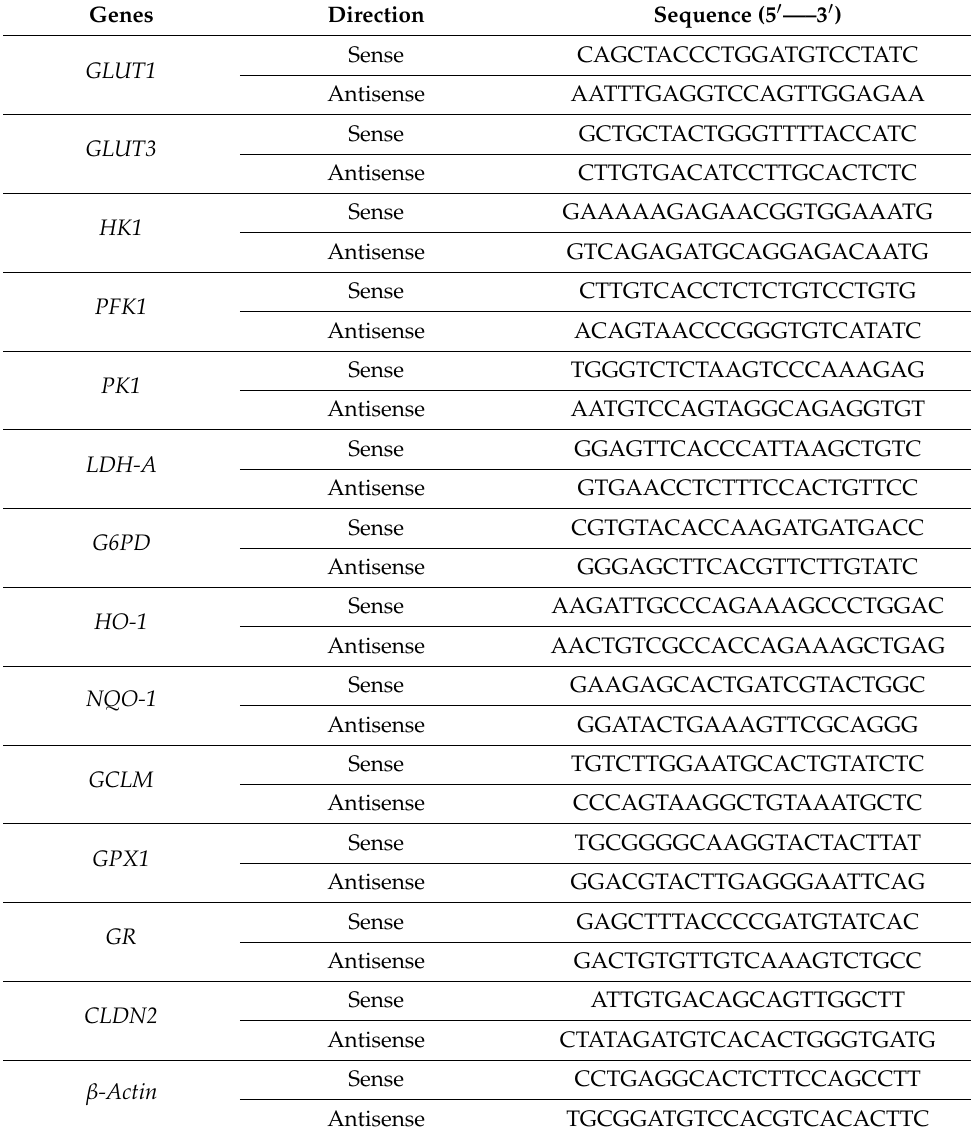
Table 1. Primer pairs for real-time PCR.